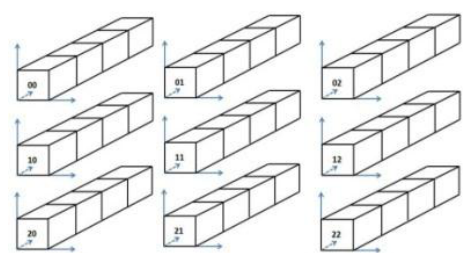
Figure 2. Diving ROI evenly into 3×3 cells and generating 9 spatiotemporal sub-cubes